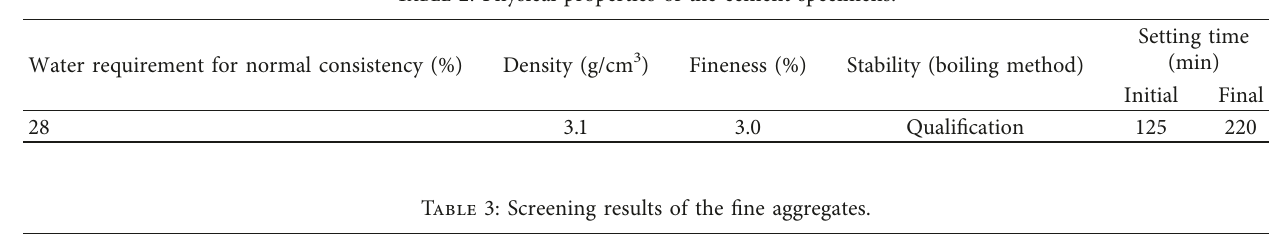
Table 2: Physical properties of the cement